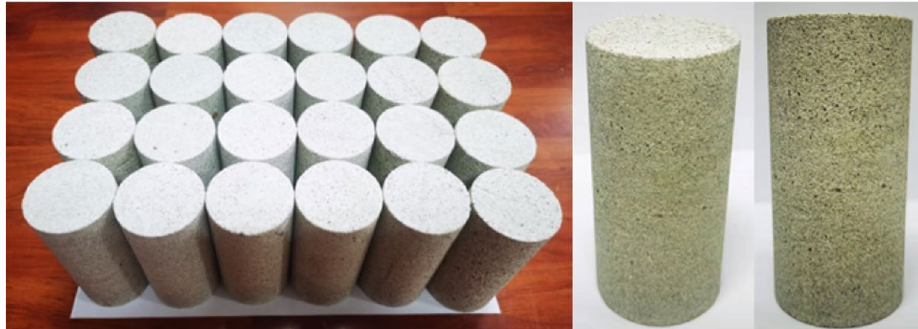
Figure 2. Rock white sandstone specimens for tests.